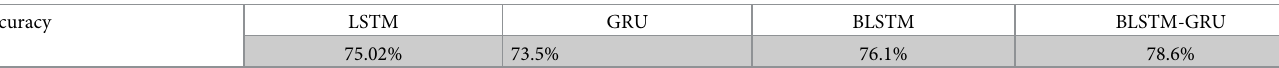
Table 4. Comparison of the proposed model with LSTM, GRU, and